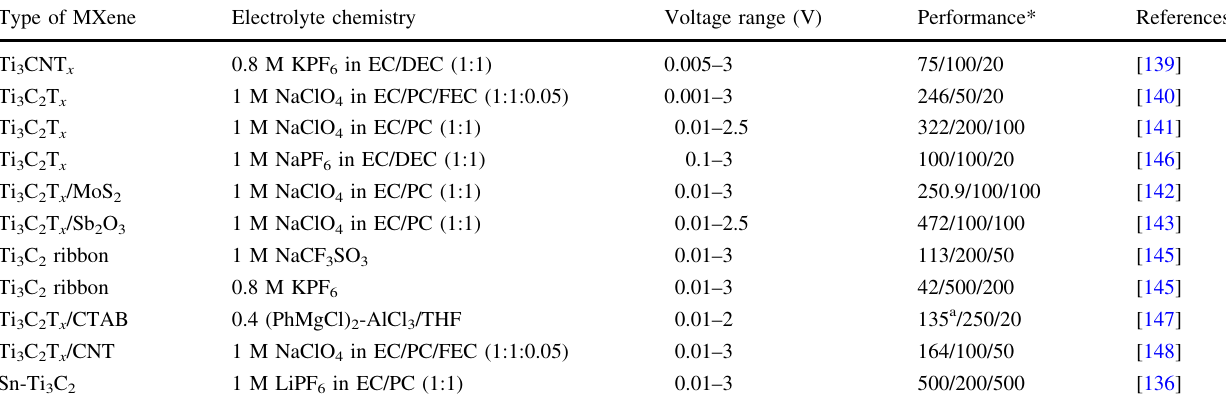
Table 4 Performance of MXene electrodes, in various non-Li metal ion rechargeable battery systems Type of